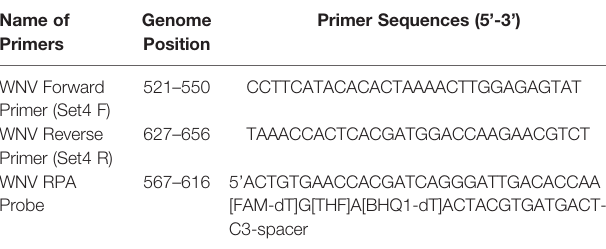
TABLE 2 | Sequences of the recombinase polymerase ampli fi cation (RPA) primers and probe used for real-time reverse transcription (RT)-RPA